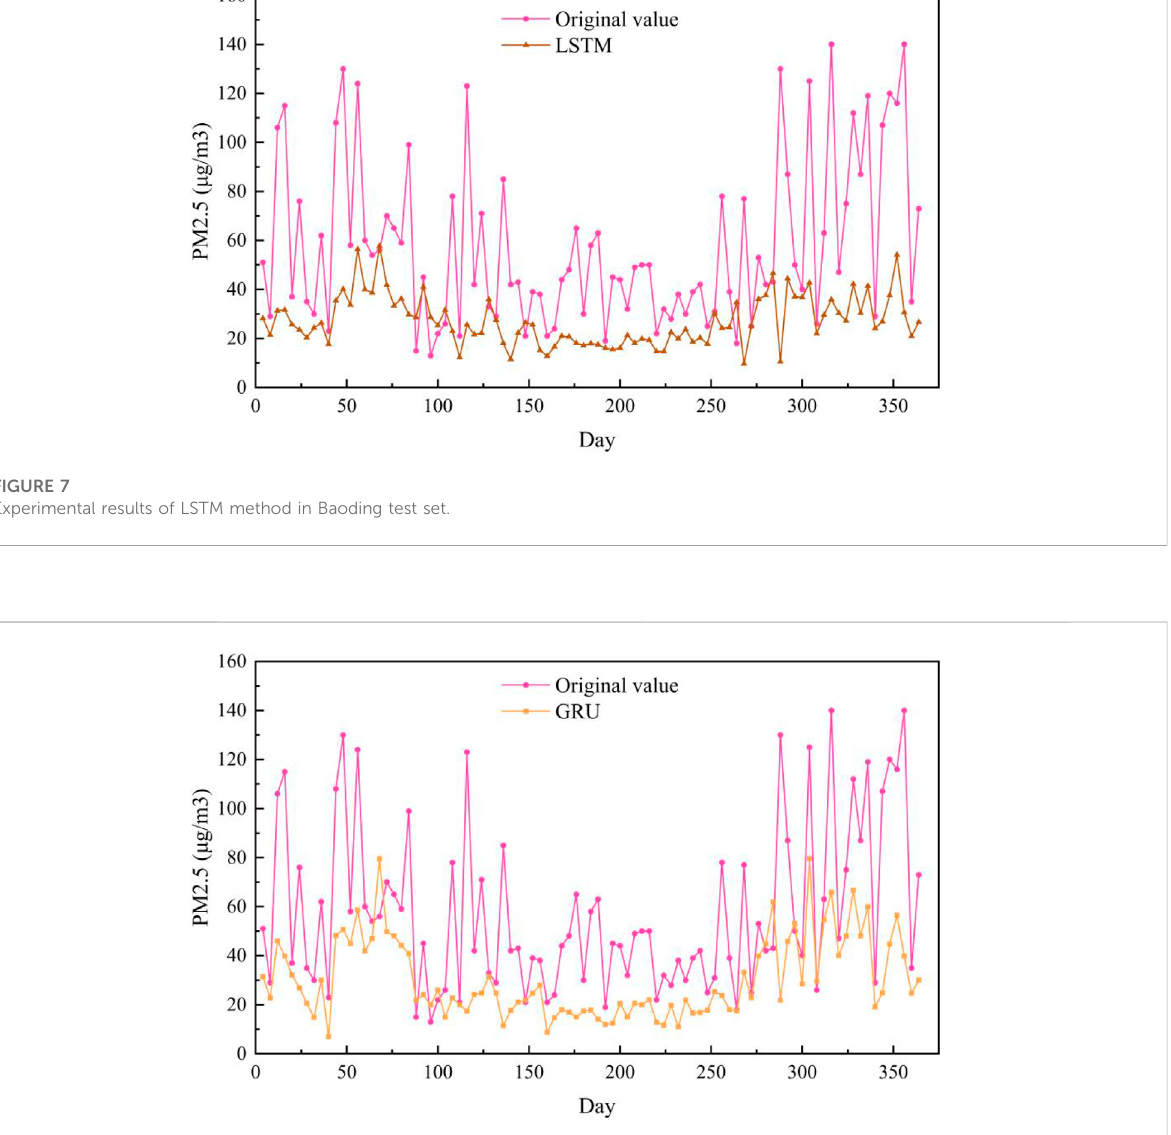
FIGURE 8 Experimental results of GRU method in Baoding test